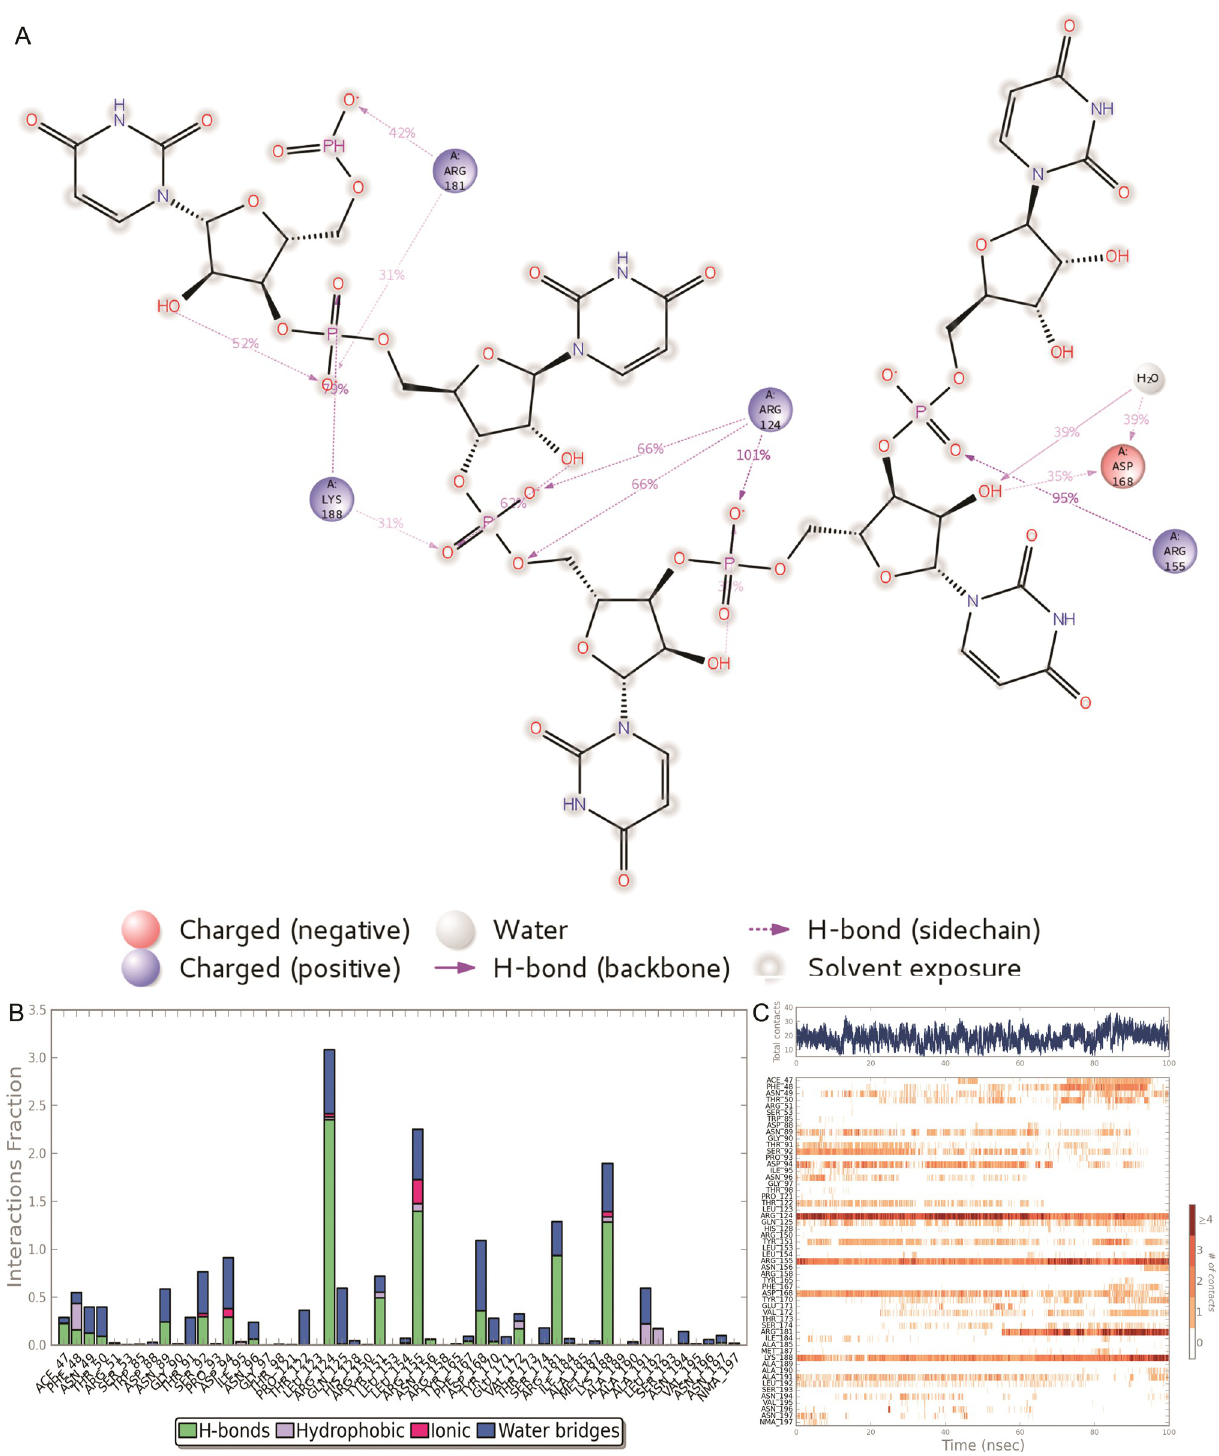
Fig 8. The H-bond occupancy of wild type YBMV CP with RNA throughout the trajectory. ( A ) 2D interaction of RNA with YBMV CP during simulation ( B ) the amino acid residues involved in the interactions ( C ) the overall interaction of the protein with RNA.